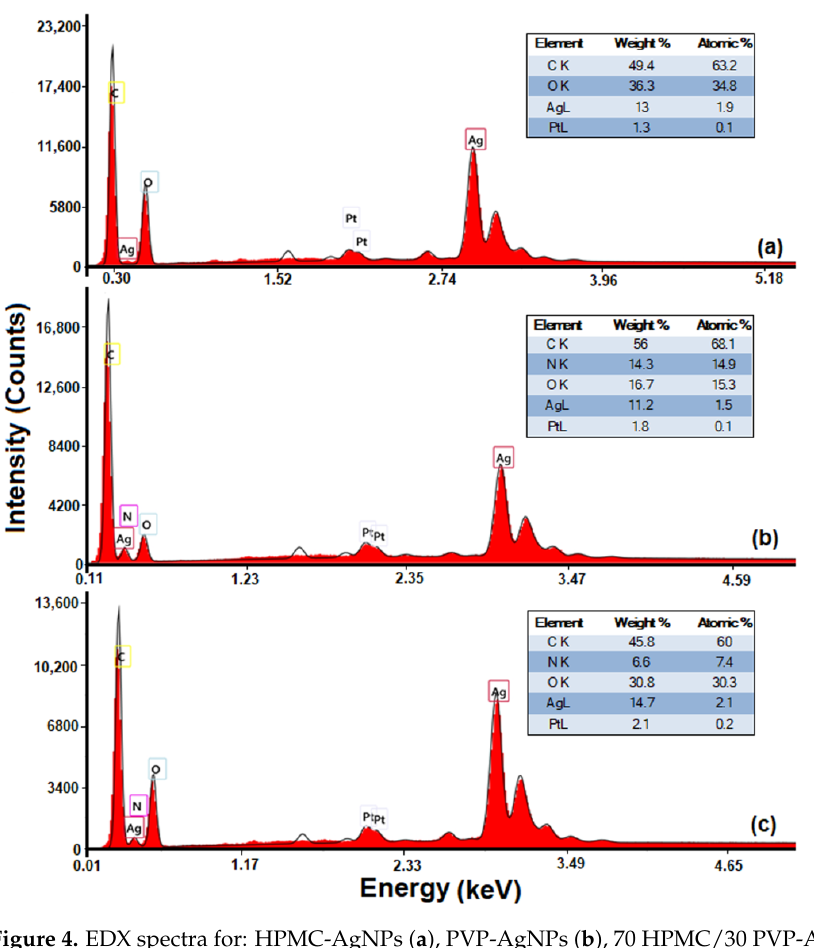
Figure 4. EDX spectra for: HPMC-AgNPs ( a ), PVP-AgNPs ( b ), 70 HPMC/30 PVP-AgNPs ( c ).